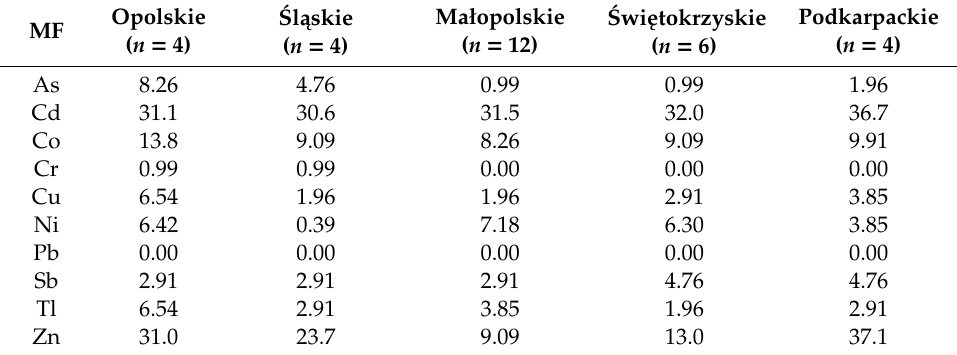
Table 5. The mobility factor (MF) values of individual PHEs of the agricultural soils in the Regions of southern